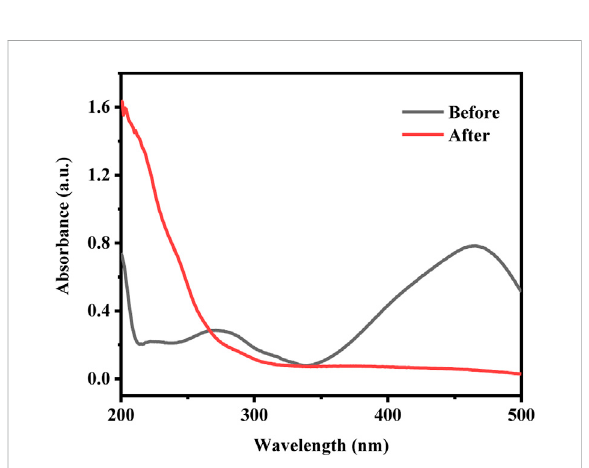
FIGURE 11 | The UV-Vis absorption spectra of the reaction solution before and after Fenton